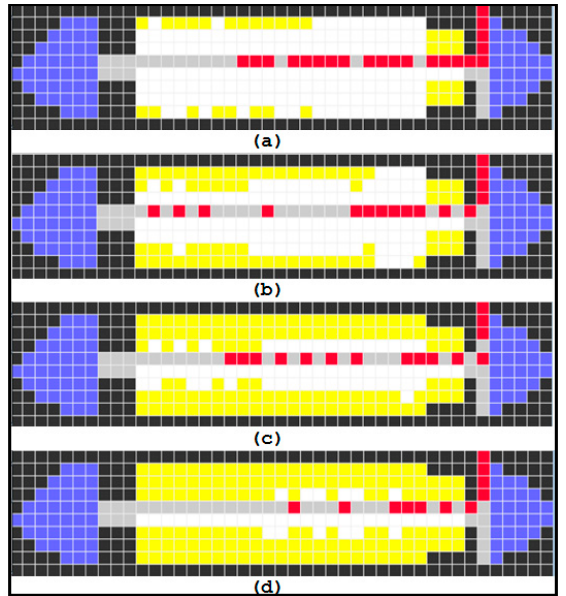
Figure 26. Reverse pyramid strategy.